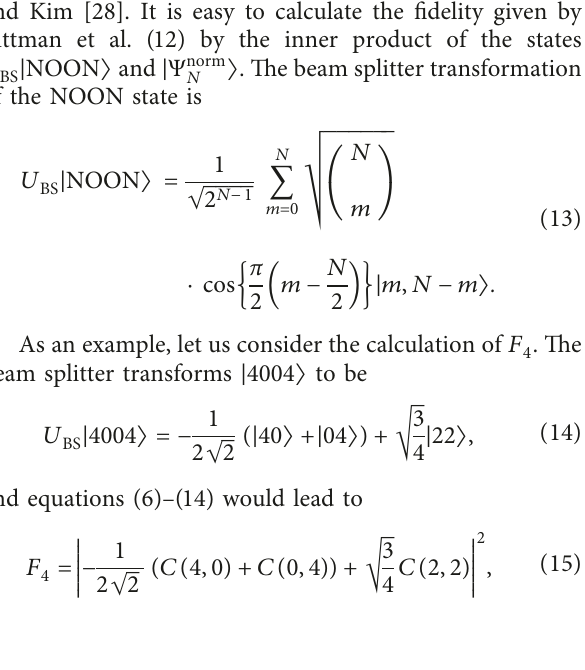
Figure 2: The setup for the quantum interferometer using coherent beam stimulated PDC. The modes 􏽢 a , β beams α , and noncollinear PDC modes. They enter the Mach–Zehnder interferometer through the first beam splitter (BS), and at the 0 0 exit BS, they are detected in a coincidence measurement by the photon number resolving